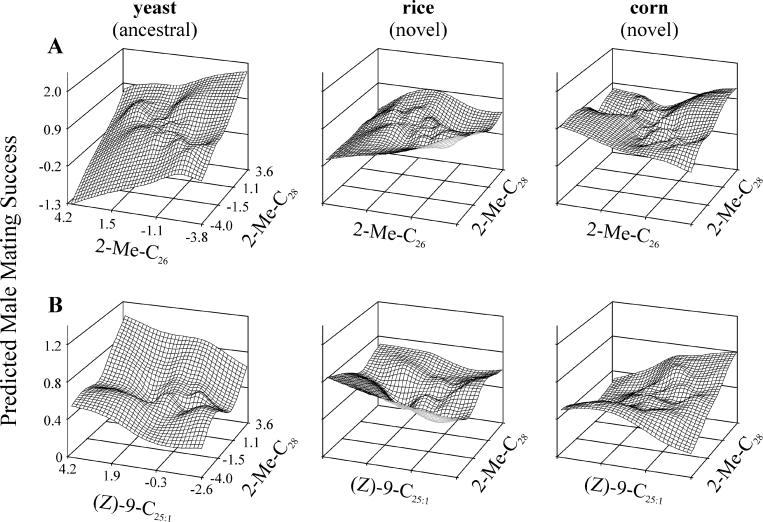
Thin-Plate Spline Representations of Bivariate Fitness Surfaces for Male CHCs for Which Female Mating Preferences Evolved in Correlation with Treatment Environment(A) Visualization of the fitness surface of the two male CHCs for which linear sexual selection varied most among treatments.(B) Visualization of the fitness surface of the two male CHCs for which nonlinear sexual selection varied most among treatments.The four replicate populations within each treatment were pooled in each case. To aid in comparisons across treatments, a single smoothing parameter (λ) was chosen that gave the lowest generalized cross-validation score in all three treatments [43] separately for (A) (λ = −1.0) and (B) (λ = −0.2).